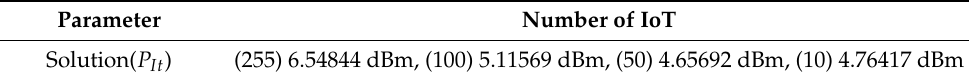
Table 5. Optimized transmission power according to the number of IoT